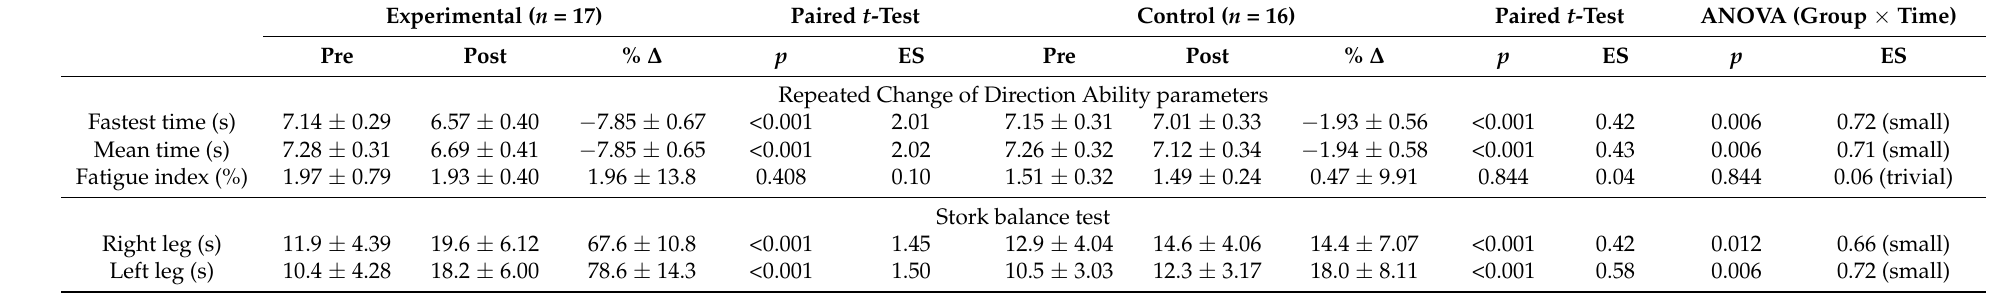
Table 5. Repeated change-of-direction ability and stork balance test performances in experimental and control groups before and after the 8-week intervention. Experimental ( n = 17) Paired t -Test Control ( n = 16) Paired t -Test ANOVA (Group × Time) Pre Post % ∆ p ES Pre Post % ∆ p ES p ES Repeated Change of Direction Ability parameters Mean time